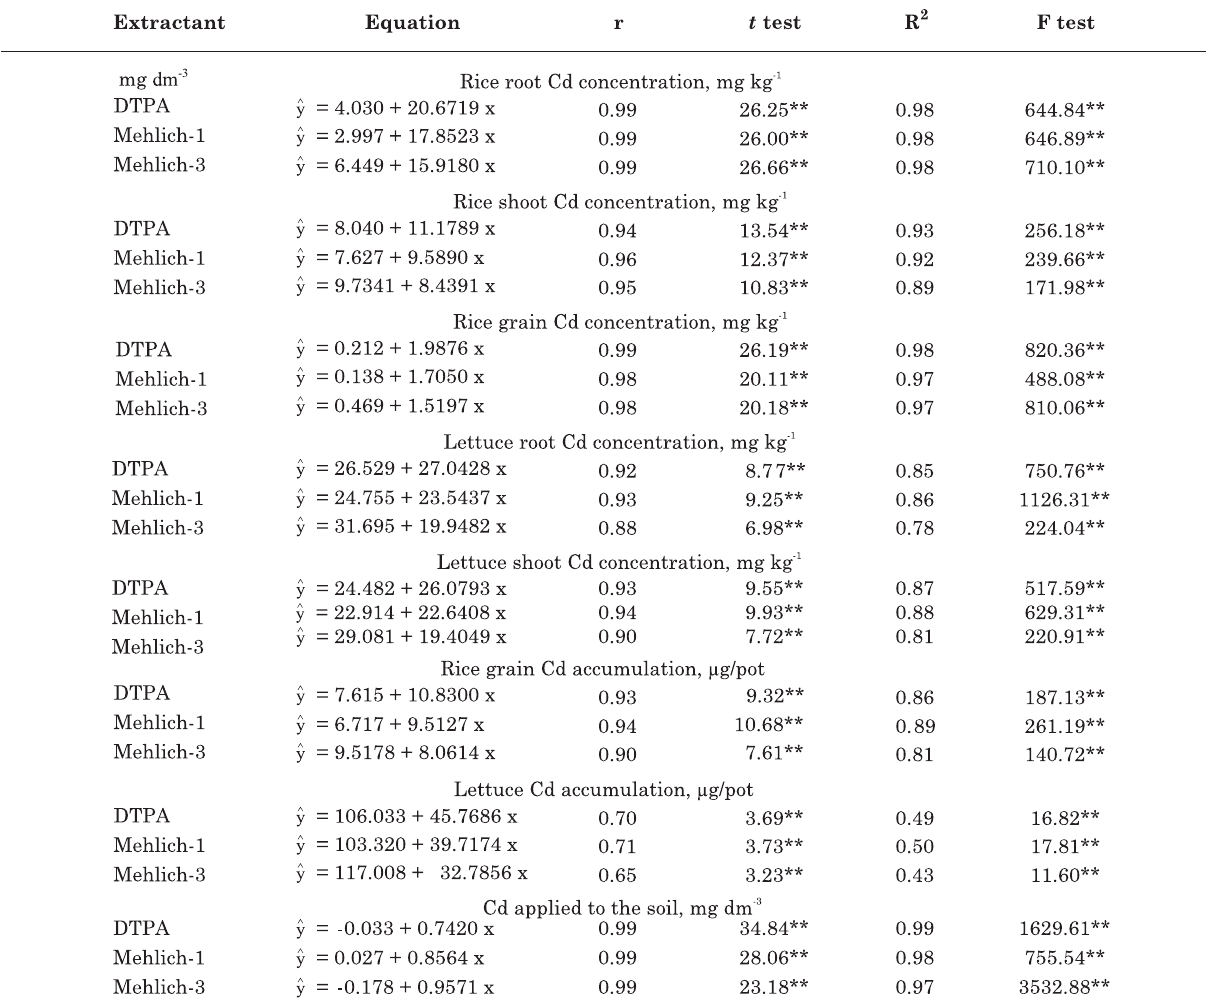
Table 1. Correlations between Cd concentrations and accumulation in rice and lettuce plant parts and